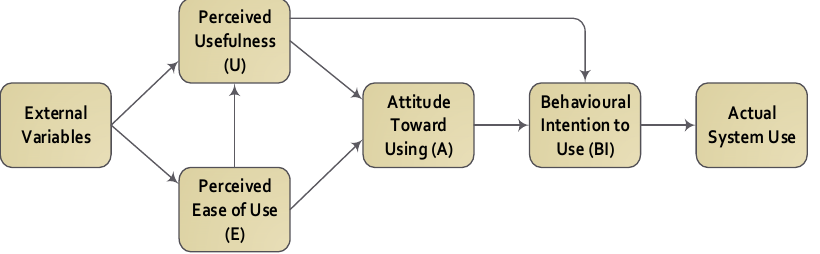
Figure 1. Technology Acceptance Model (TAM).